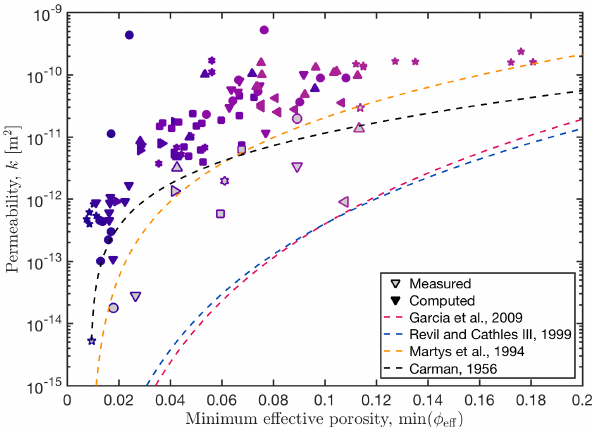
Figure B1. Computed and measured permeability against minimum effective porosity. Symbols of the same shape and colour represent the same sample. Samples with a grey face represent measured val- ues, whereas colour-only symbols stand for computed subsamples.